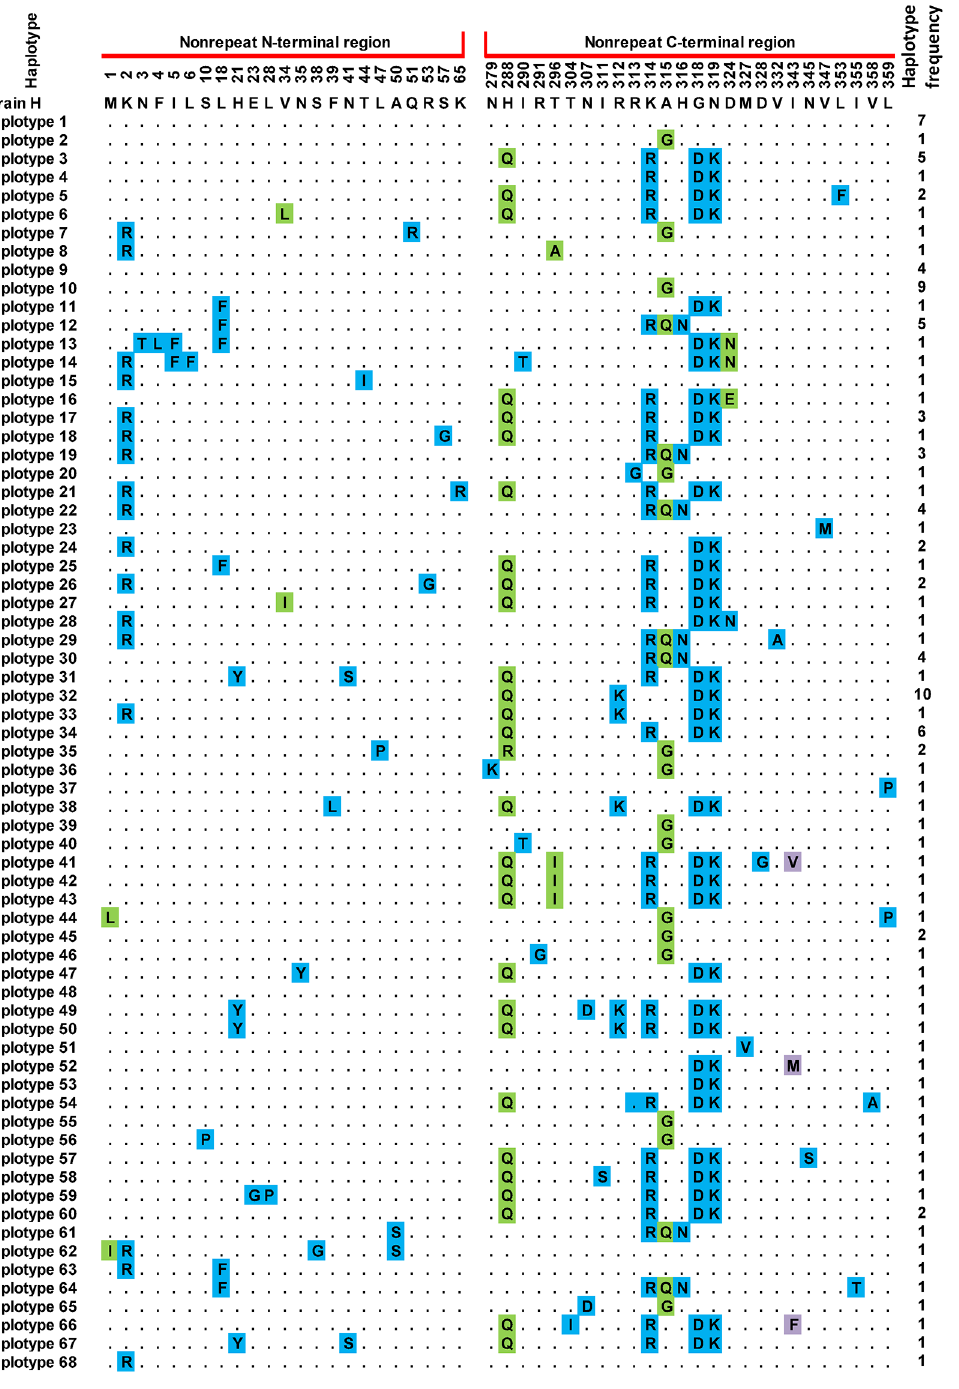
Fig 2. Amino acid sequence polymorphism in the P . knowlesi CSP N- and C-terminal nonrepeat regions. Polymorphic amino acid residues are listed for each haplotype. Residues identical to those of the reference sequence (strain H) are marked by dots. Monomorphic, dimorphic and trimorphic changes at a particular amino acid position are shaded blue, green and purple, respectively. Total number of sequences for each haplotype is listed in the right panel.